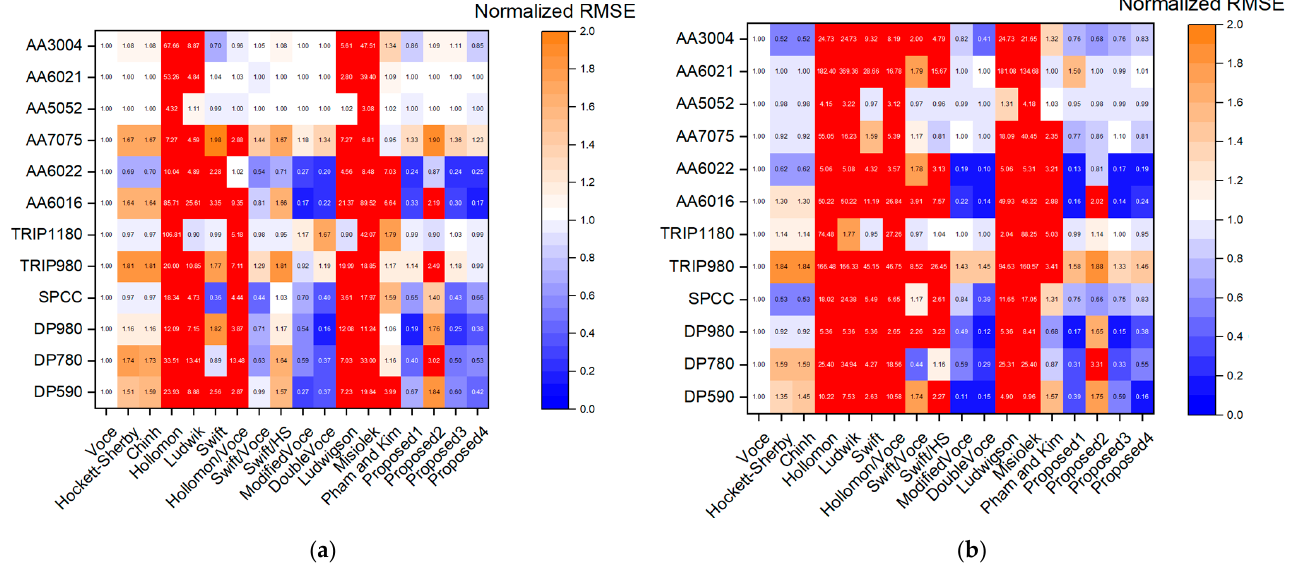
Figure 7. Normalized RMSE of hardening rate predictions. ( a ) Hardening laws identified by the common curve fitting method. ( b ) Hardening laws identified by the constrained curve fitting method.